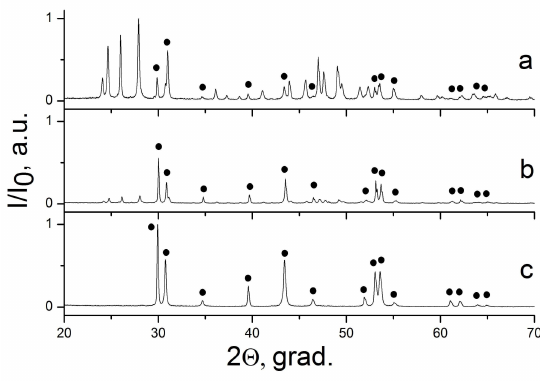
Figure 2. X-ray diffraction patterns of samples in the NaF–YF 3 system synthesized at 320 ◦ C, ratios of Y(NO 3 ) 3 :NaF:NaNO 3 starting materials: 11:30:59 ( a ) (sample 1); 9:39:52 ( b ) (sample 2); 7:52:41 ( c ) (sample 3). NaYF 4 phase lines are marked with solid circle symbols.